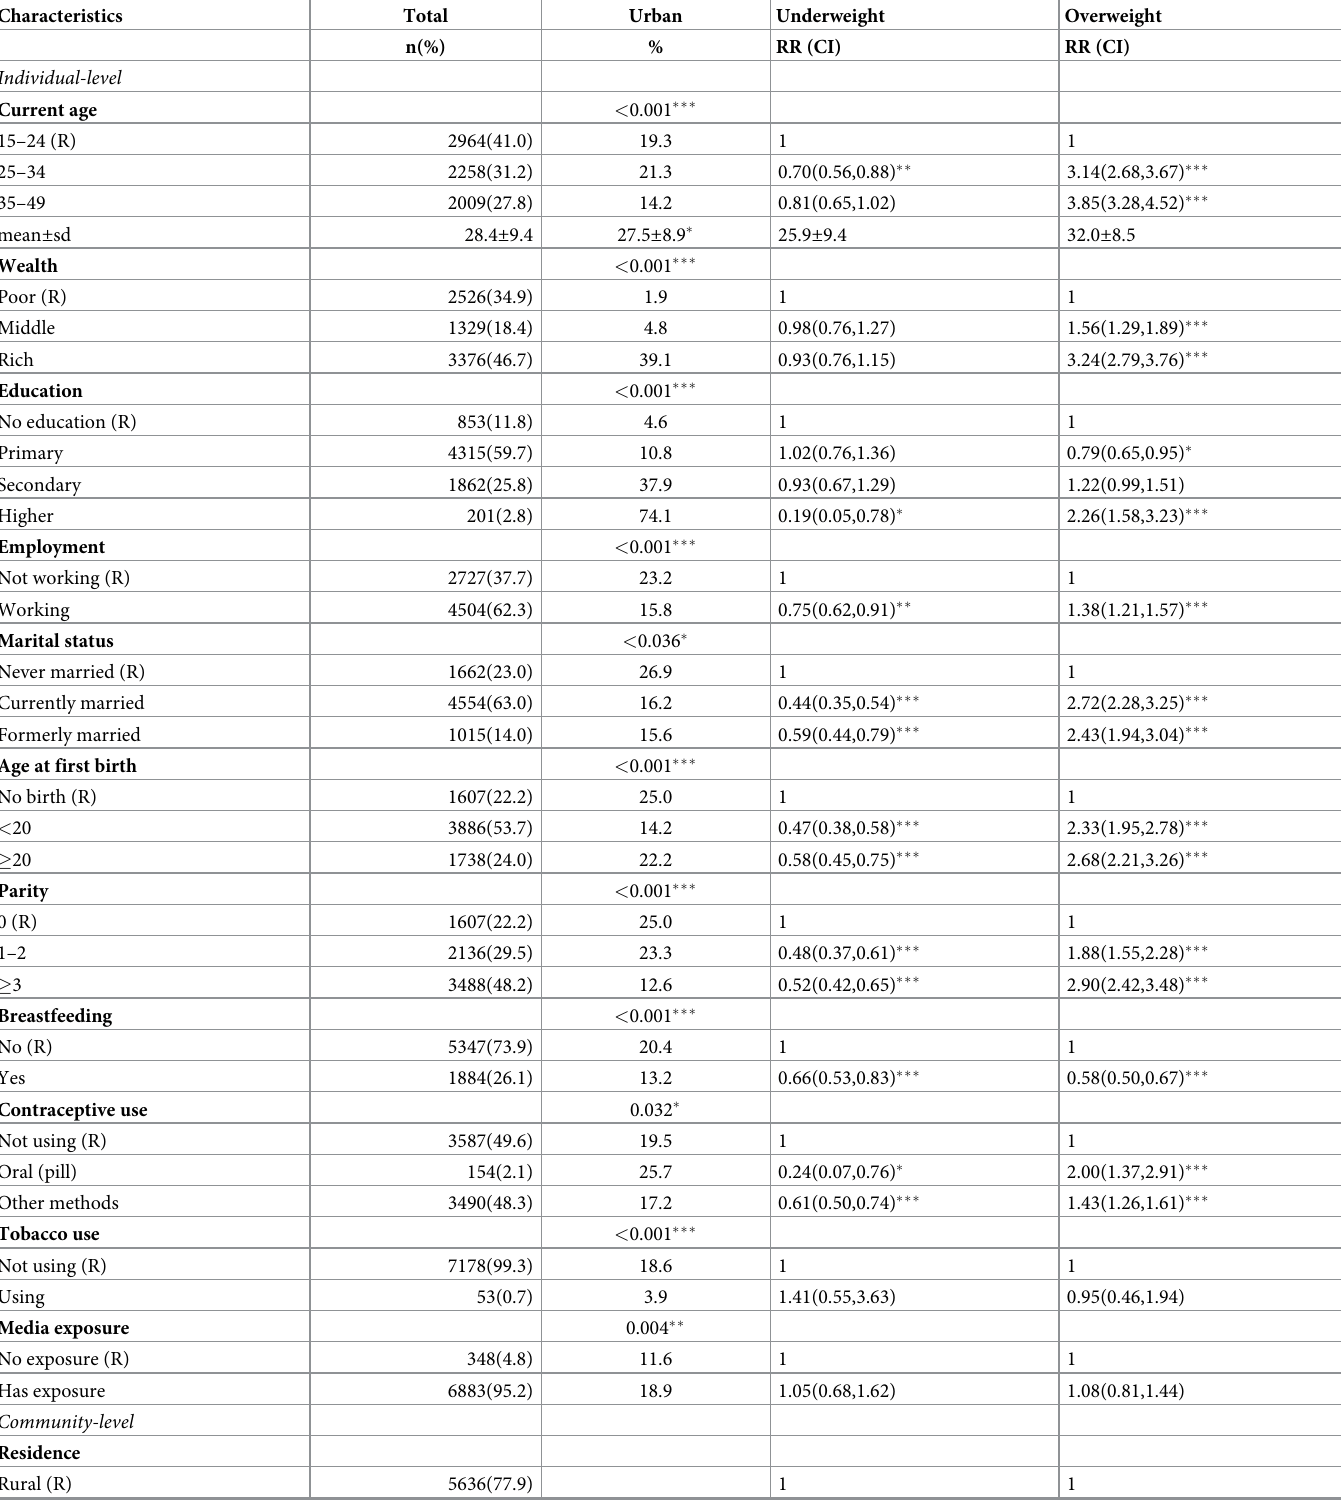
Table 1. Distribution of participants by urban residence and unhealthy bodyweight association with individual- and community-level characteristics.